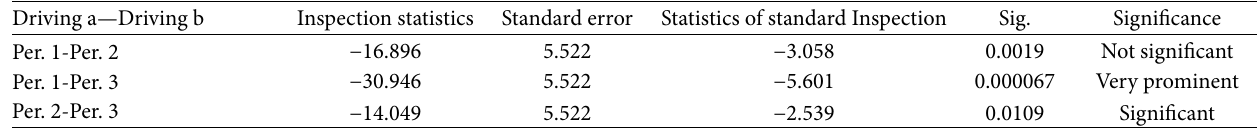
Table 5: Difference of psychological with load subjective evaluation under different driving tasks (night). Driving a—Driving